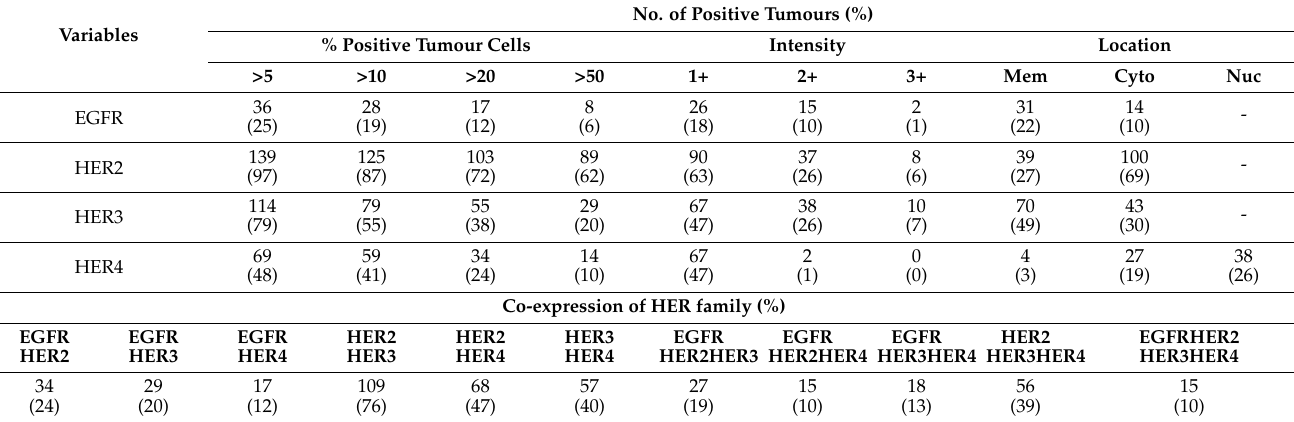
Table 2. Immunohistochemical expression of HER family members and their co-expressions in 144 mCRC patients treated with anti-EGFR